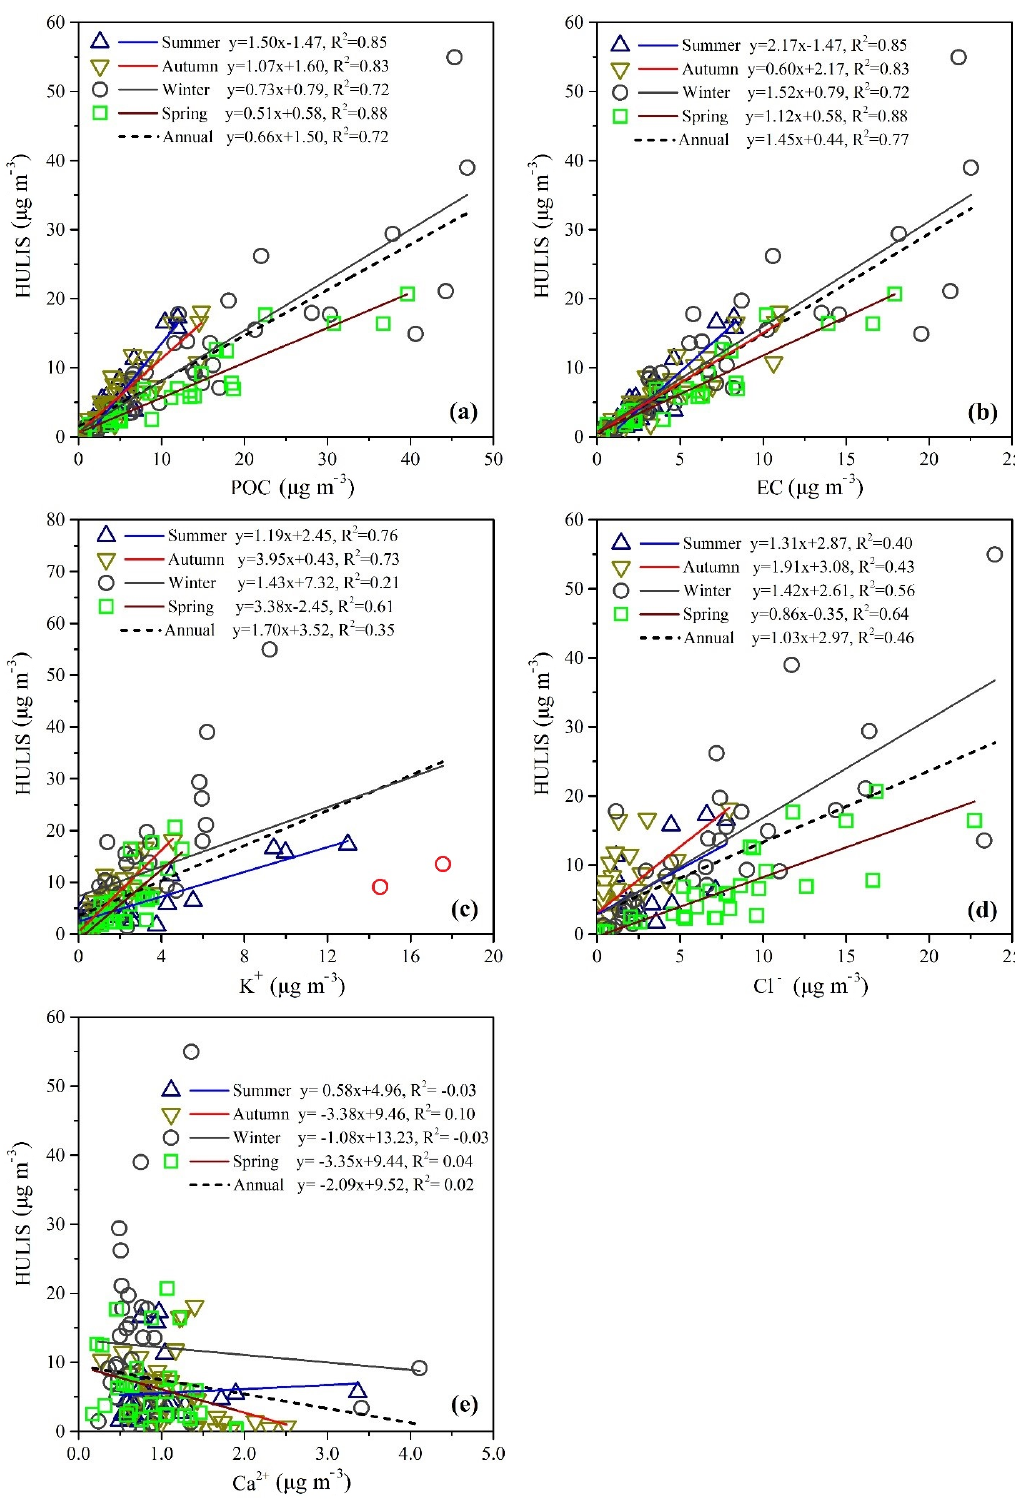
Figure 2. Correlations between HULIS and POC (a) , HULIS and EC (b) , HULIS and K + (c) , HULIS and Cl − (d) , and HULIS and Ca 2 + (e) . Concentrations in four seasons are represented by different shapes with different colors. Linear regressions are also given with corresponding